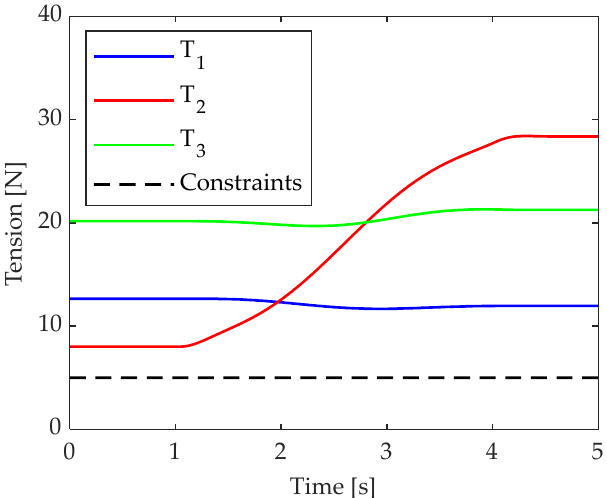
Figure 11. Cable tensions in the execution of the straight line.